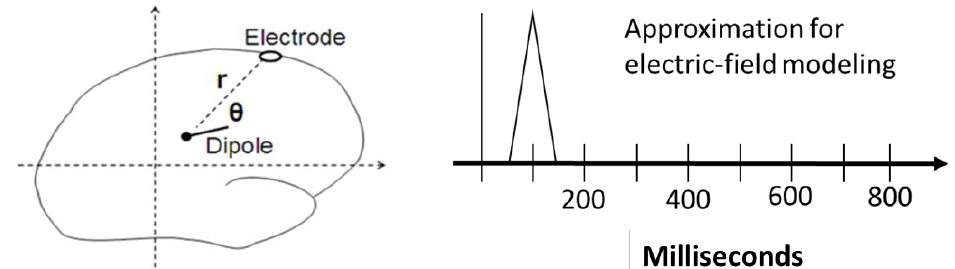
Figure 3. Schematic representation of the calculation of an electric dipole field spiking by simulation; the left panel shows the output of the calculated electric-field potential represented as a simplified spike at fixed timing (determined by the simulated production schedule, here shown at an arbitrary time point for example sake; for the actual simulated timings in the present study see the production schedule shown in Table